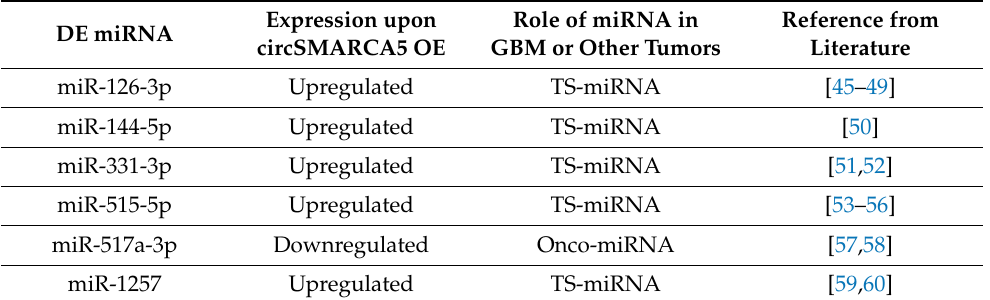
Table 1. Upregulated TS miRNAs and downregulated onco-miRNAs chosen as candidate DE miRNAs to be further analysed through single TaqMan ® assays. Expression upon